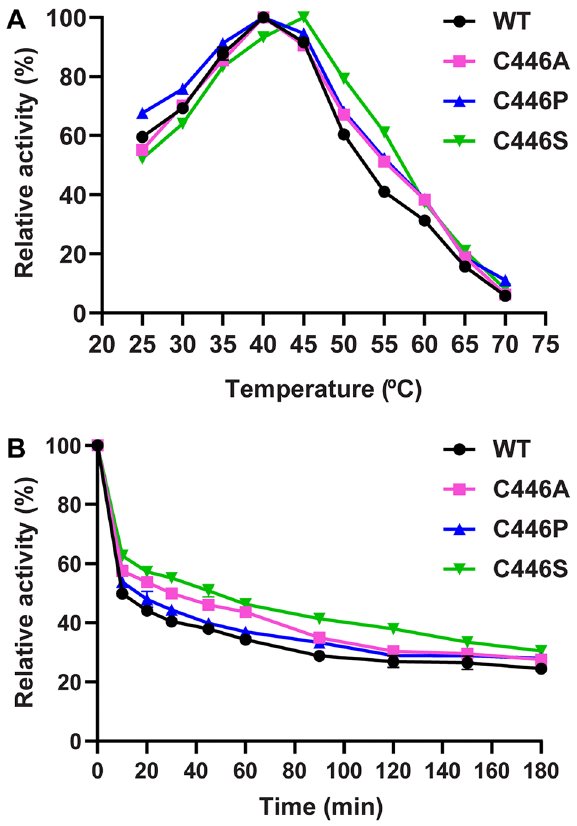
Figure 3. ( A ) Optimum temperature of WT and C446 mutated Sa AM. ( B ) Effect of temperature on Sa AM stability. WT and C446 mutated Sa AMs were incubated in phosphate buffer pH 6.0 at 45 °C from 0 to 180